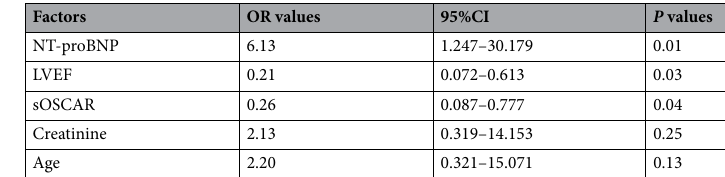
Table 2. Independent risk factors of MACE occurring within 30 days after ACS by multivariate Logistic regression analysis. MACE major adverse cardiovascular events; ACS acute coronary syndrome; NT-proBNP N-terminal pro brain natriuretic peptide; LVEF left ventricular ejection fraction; sOSCAR soluble osteoclast- associated